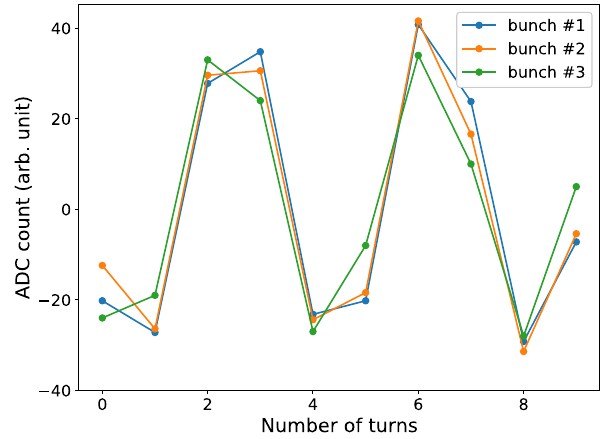
FIG. 3. In-phase excitation of the DBT through resonance driving. Here the vertical ADC counts of three out of ten bunches are shown. The signals are measured by the dedicated BPM used as the BBFB ’ s pickup, and its digitizer can distinguish different bunches in the train.